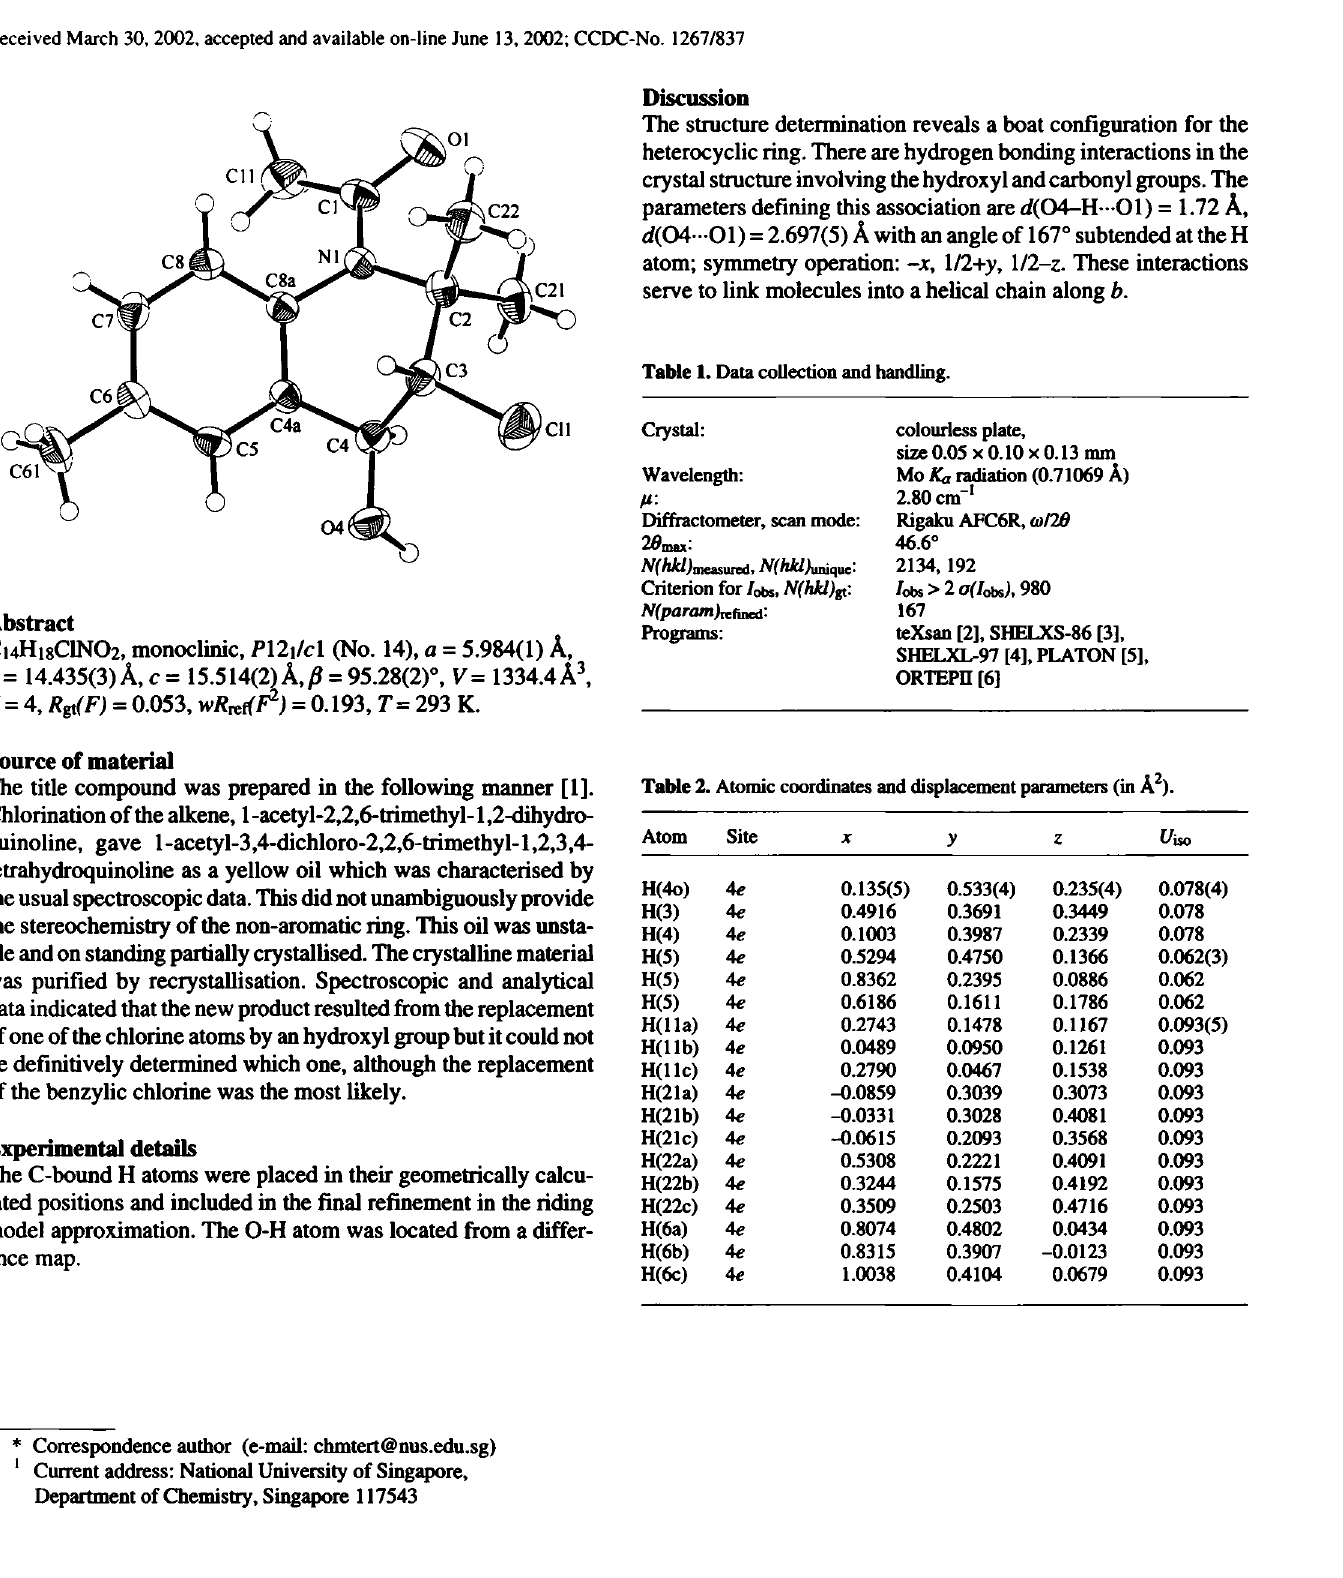
Table 1. Data collection and handling.